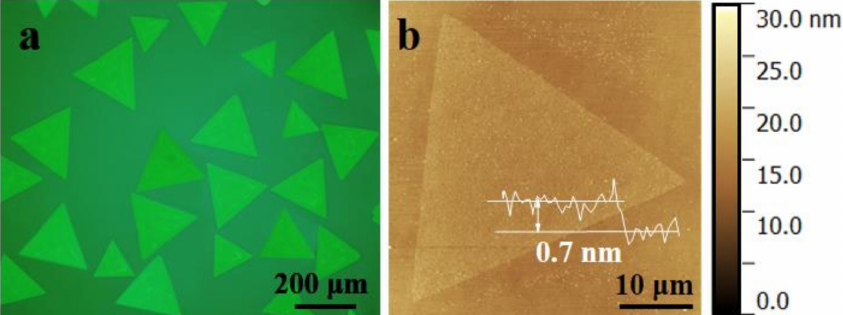
Figure 1. ( a ) Optical microscope images of the monolayer WS 2 . ( b ) AFM images of the monolayer WS 2